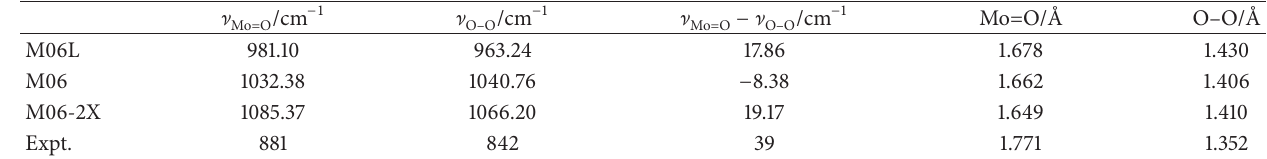
Table 6: Mo=O and O–O stretching, and Cp’s C–H OOP bending frequencies for 1-Cl